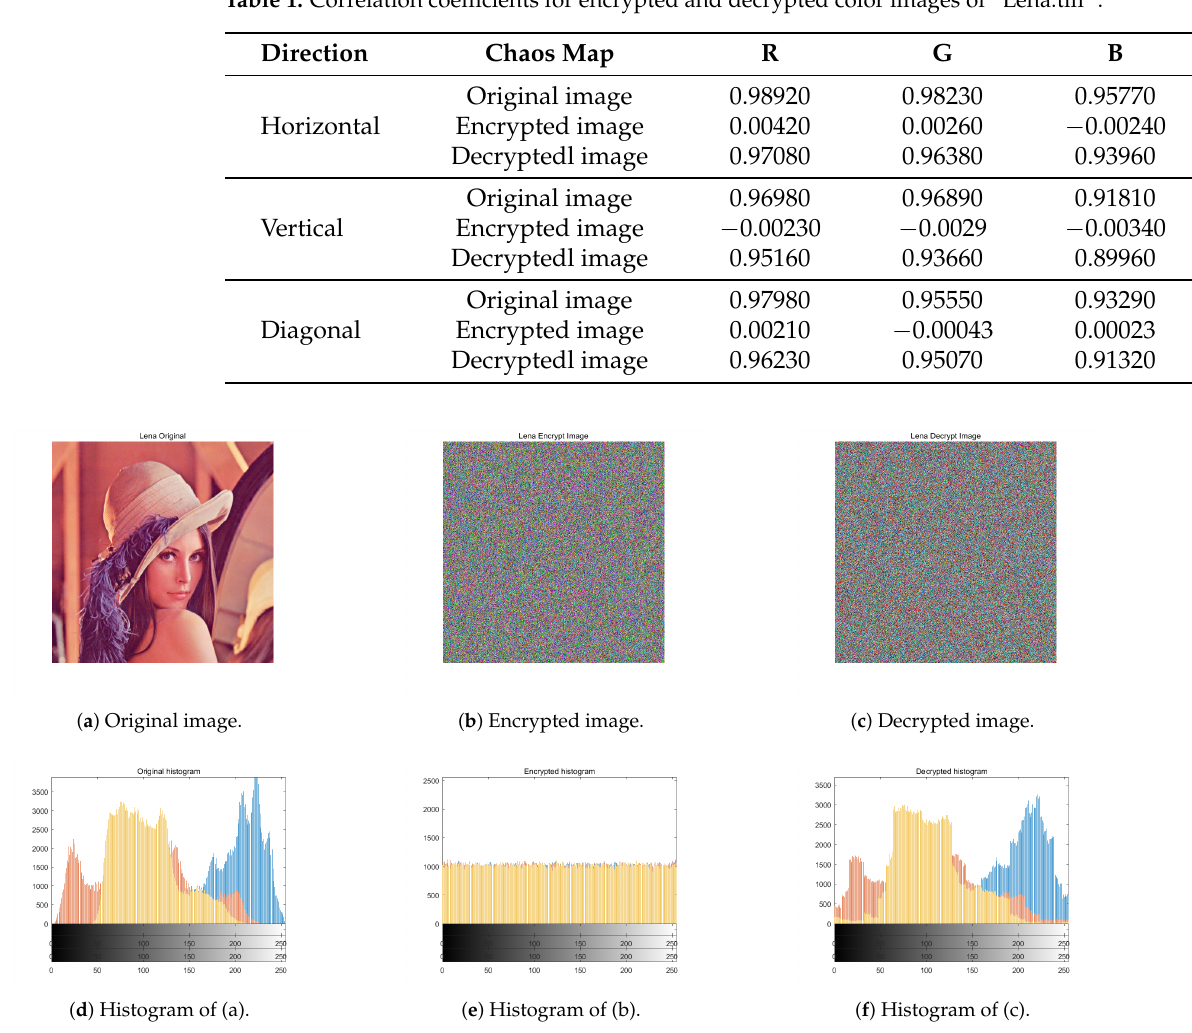
Figure 4. Encryption and decryption of “Lena.tiff.” when the system is not